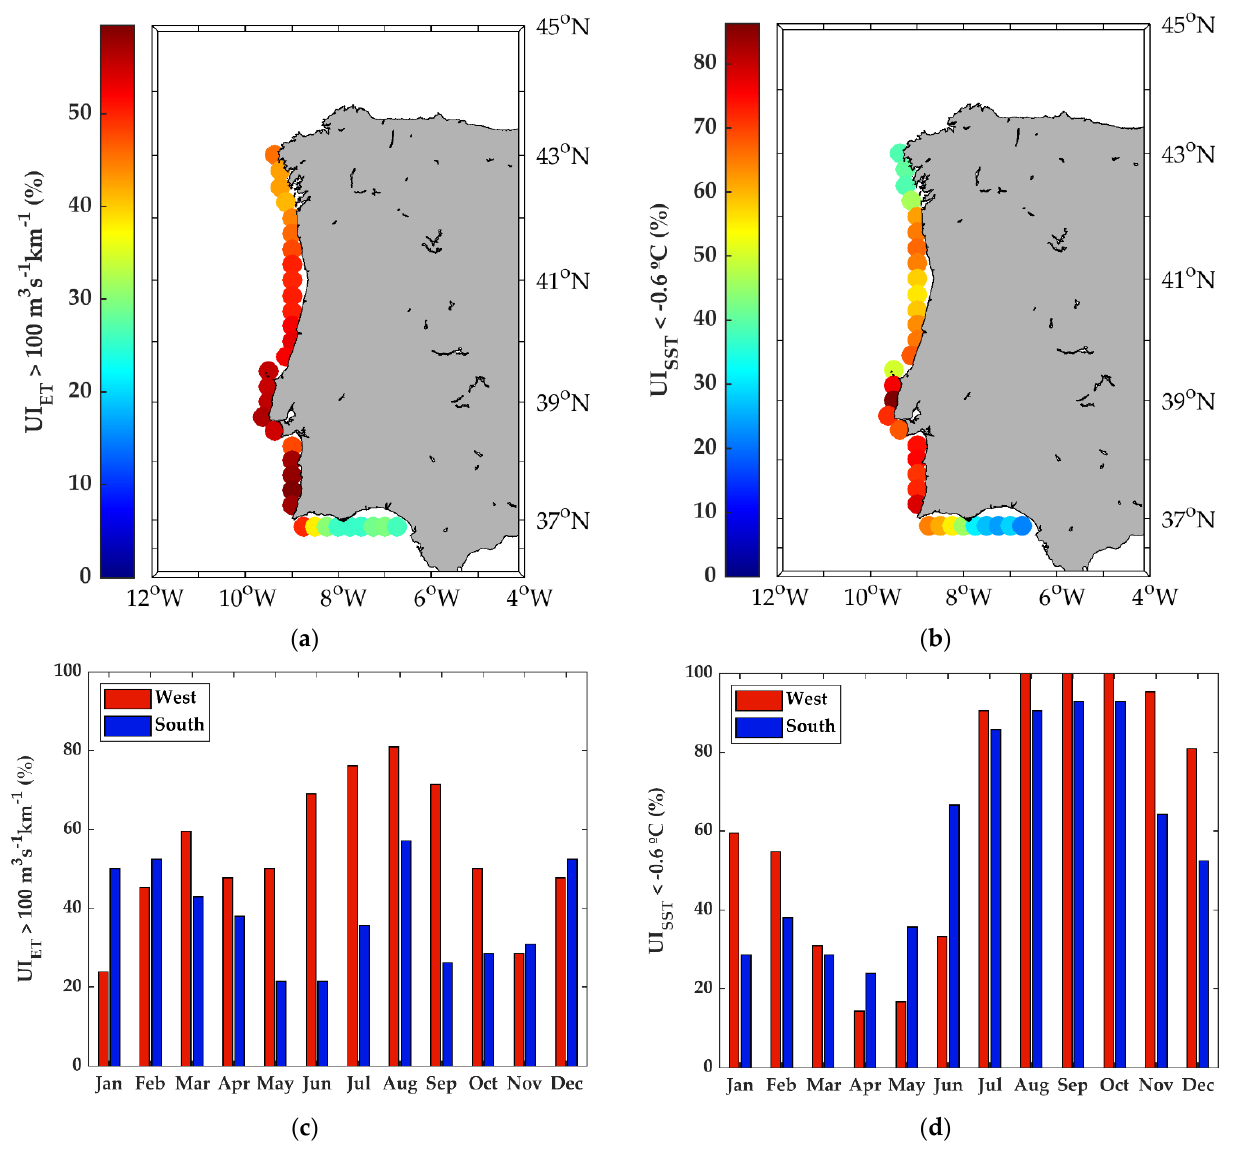
Figure 2. Percentage of upwelling-favourable conditions (occurrences) based on Ekman transport and SST indexes: ( a ) percentages of months with UI ET values higher than 100 m 3 s − 1 km − 1 , for each point; ( b ) percentages of months with UI SST values lower than − 0.6 °C, for each coastal point; ( c ) percentages of spatially averaged UI ET values higher than 100 m 3 s -1 km -1 , for each month of the year, on the west and south coasts; ( d ) percentages of spatially averaged UI SST values lower than − 0.6 °C, for each month of the year, on the west and south coasts.